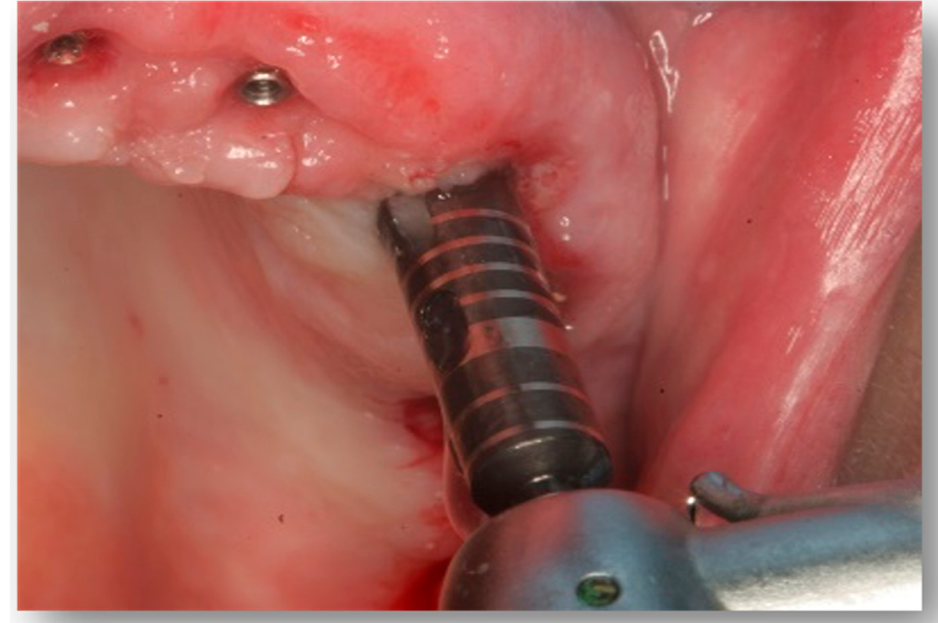
Figure 1. Core extraction with a 3.0 trephine. This is done with anesthesia, flapless, obtaining an all-tissue sample: mucosa, dentin and bone.